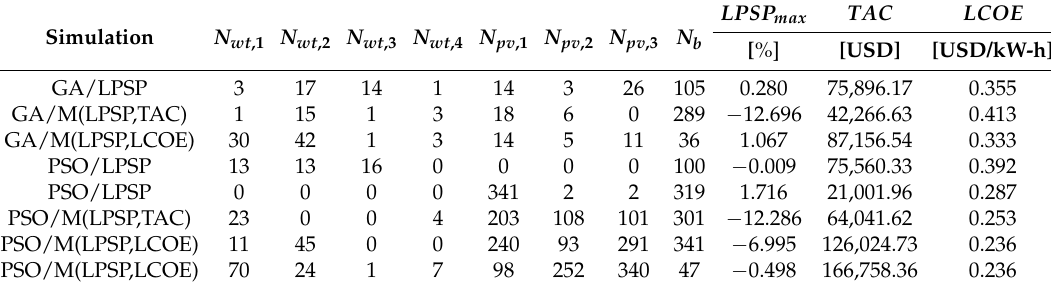
Table 9. Best results for Case III: community demand of 156.15